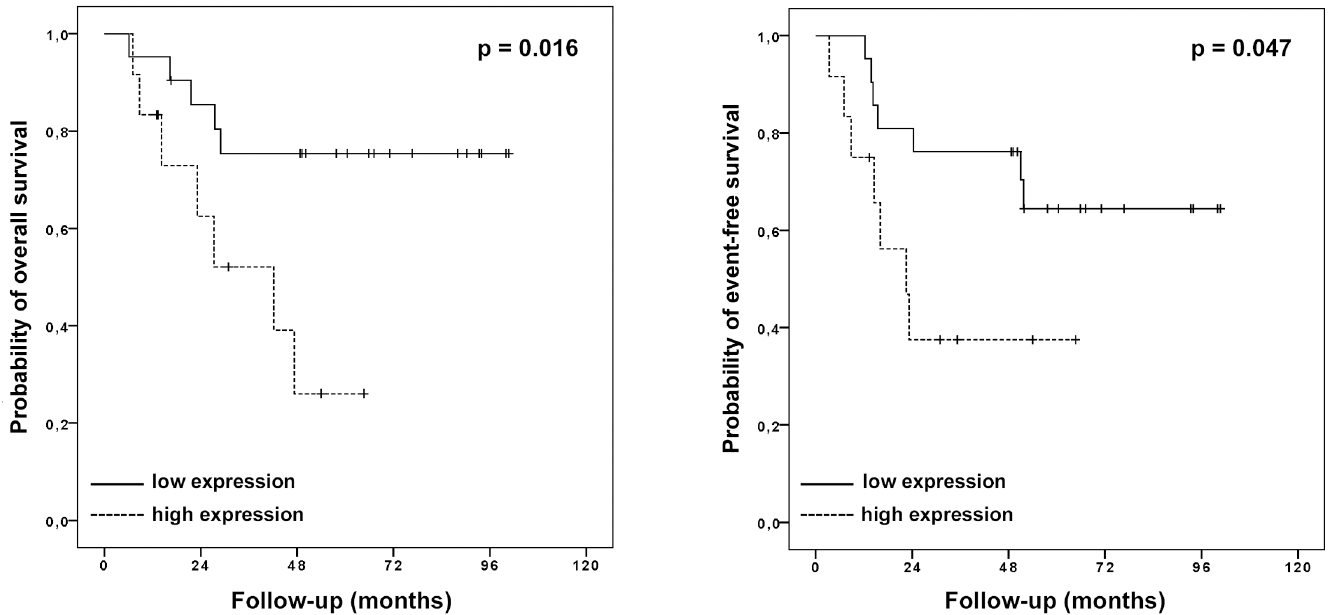
Fig 1. Kaplan-Meier survival curves of the OS patients according to HULC expression. A: overall survival, B: event-free